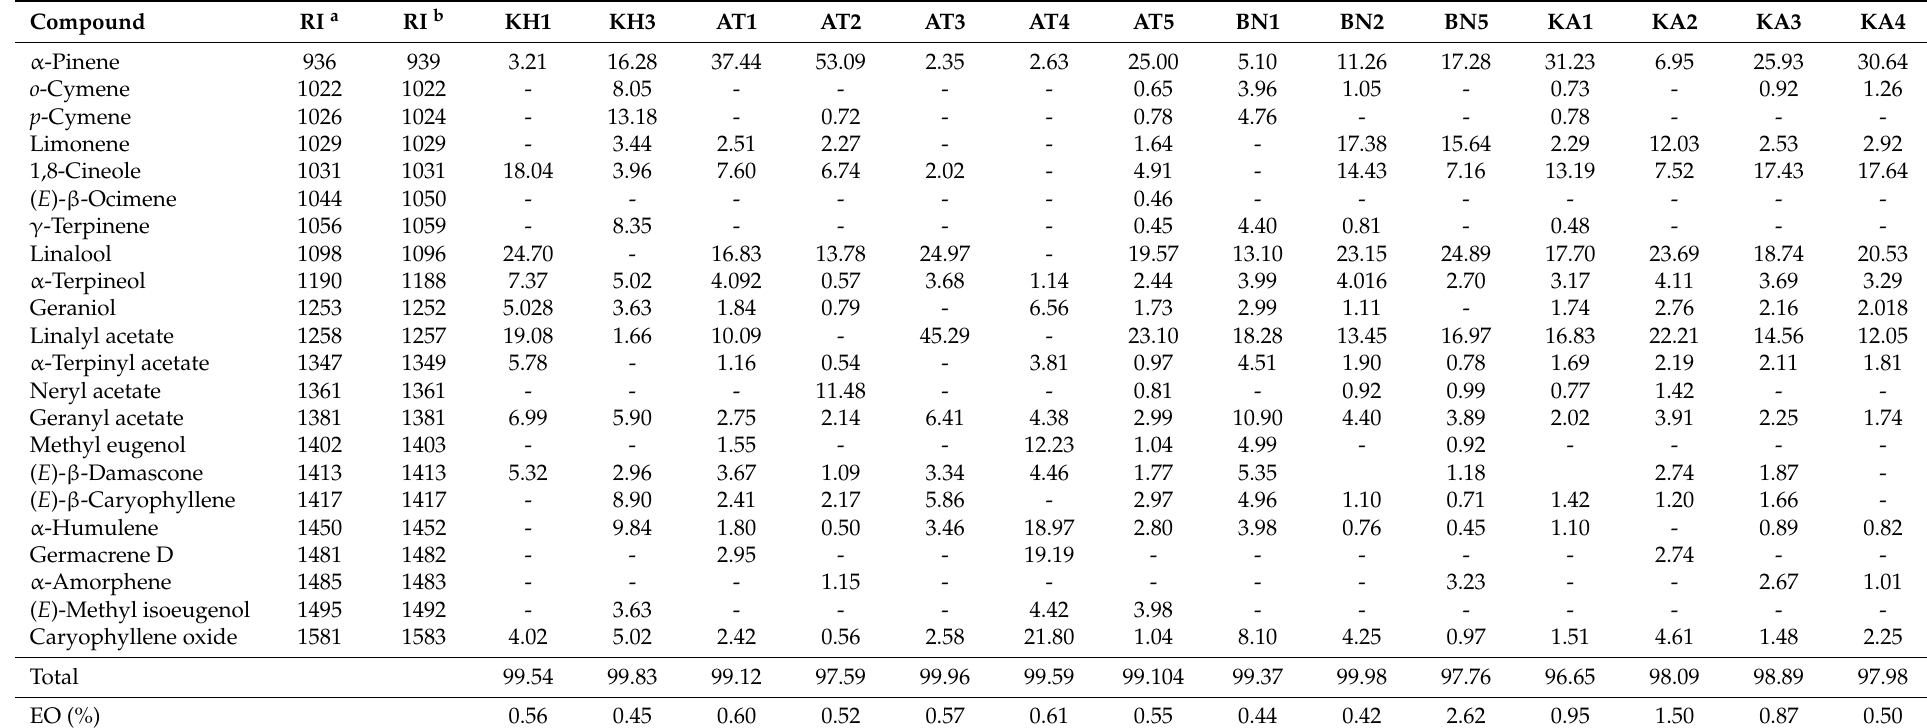
Table 1. Essential oils content and composition of 14 superior myrtle accessions under greenhouse